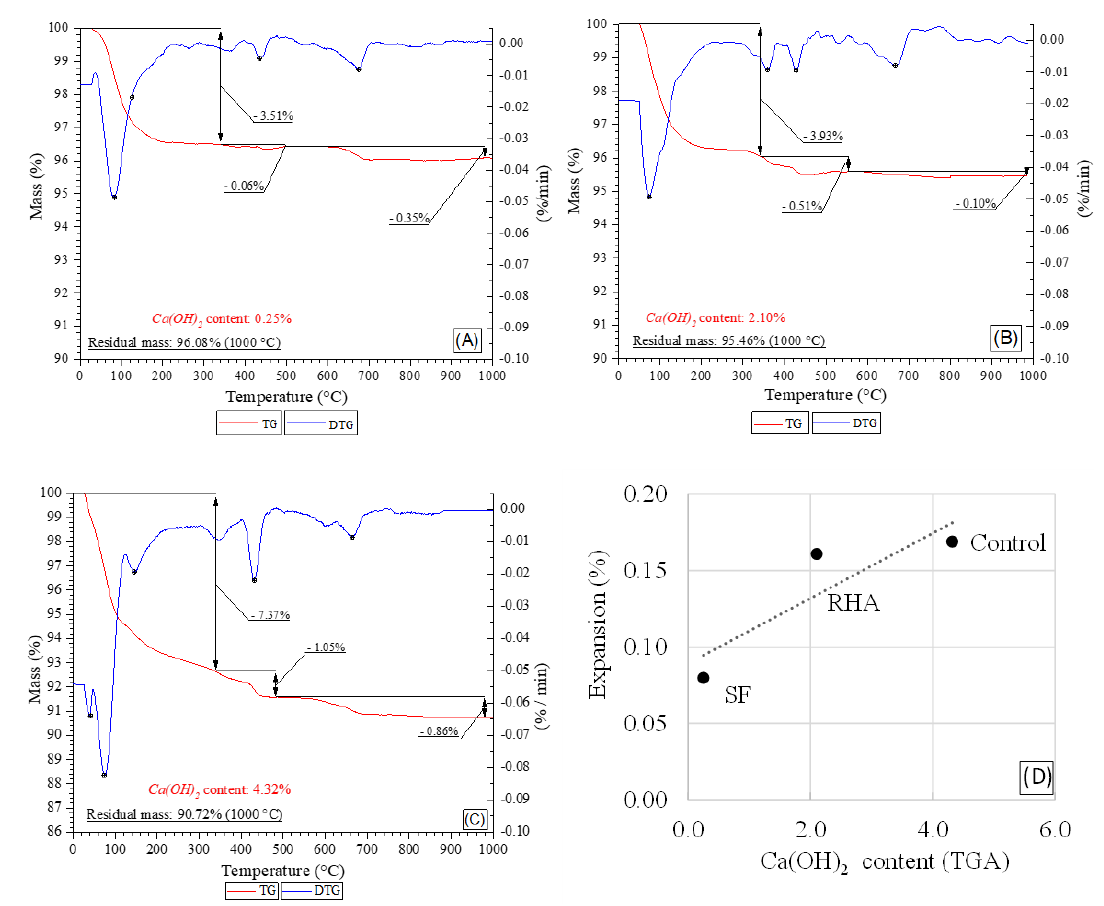
Figure 8. TGA and DTG (A) mortar with SF (B) mortar with RHA (C) Control mortar (D) Correlation between expansion (%) and portlandite content (%)